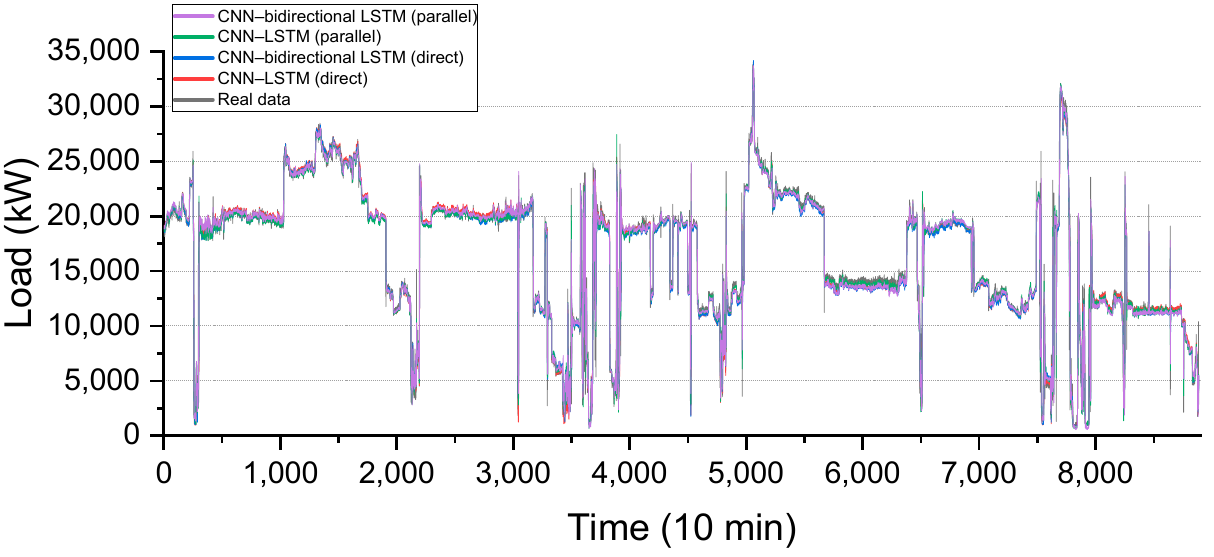
Figure 8. Result of forecasts by each model.